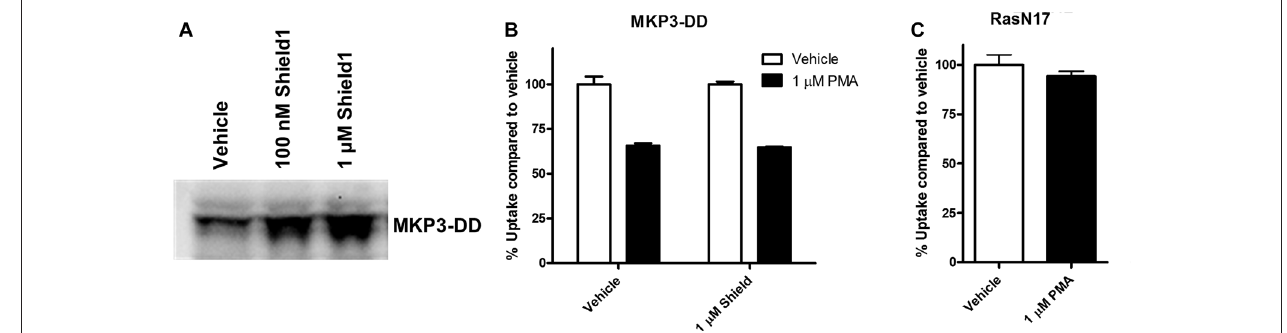
FIGURE 6 | Modulation of PKC-mediated regulation of NET activity is dependent on long term processes. A destabilized version of MKP3 (MKP3-DD) was stably expressed in PC12 cells. Short term stabilization of this destabilized MKP3 was achieved pharmacologically by a 4-h incubation with the Shield1 compound (A) . Following restoration of the MKP3 protein by Shield1 (1 µ M for 4 h) PKC was activated by PMA for 30 min and NET-specific radiolabeled uptake was performed as above comparing with vehicle treated control (B) . All experiments were performed in triplicate in three independent experiments. No significant attenuation of PKC-mediated down regulation of NET was observed following MKP3 protein restoration (two-way ANOVA with Bonferroni post hoc analysis). A dominant negative mutant of the ras protein (RasN17) was stably expressed in PC12 cells and PKC was activated by PMA for 30 min and NET-specific radiolabeled uptake was performed as above comparing with vehicle treated control (C) . All experiments were performed in triplicate in three independent experiments. PKC mediated down regulation was completely inhibited as there was no significant difference between vehicle and PMA treated cells (Student’s t